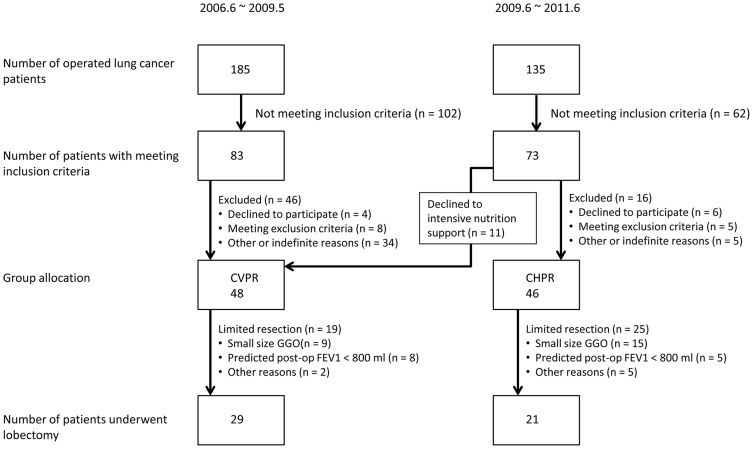
CONSORT diagram for cohort selection.